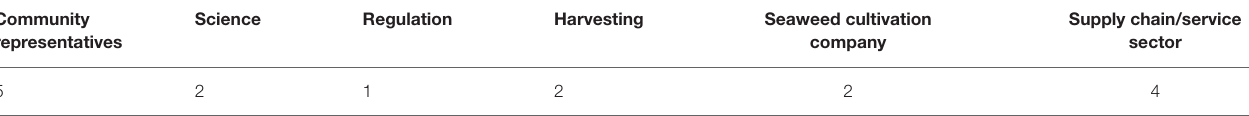
TABLE 3 | Overview of participants per sector. Community representatives